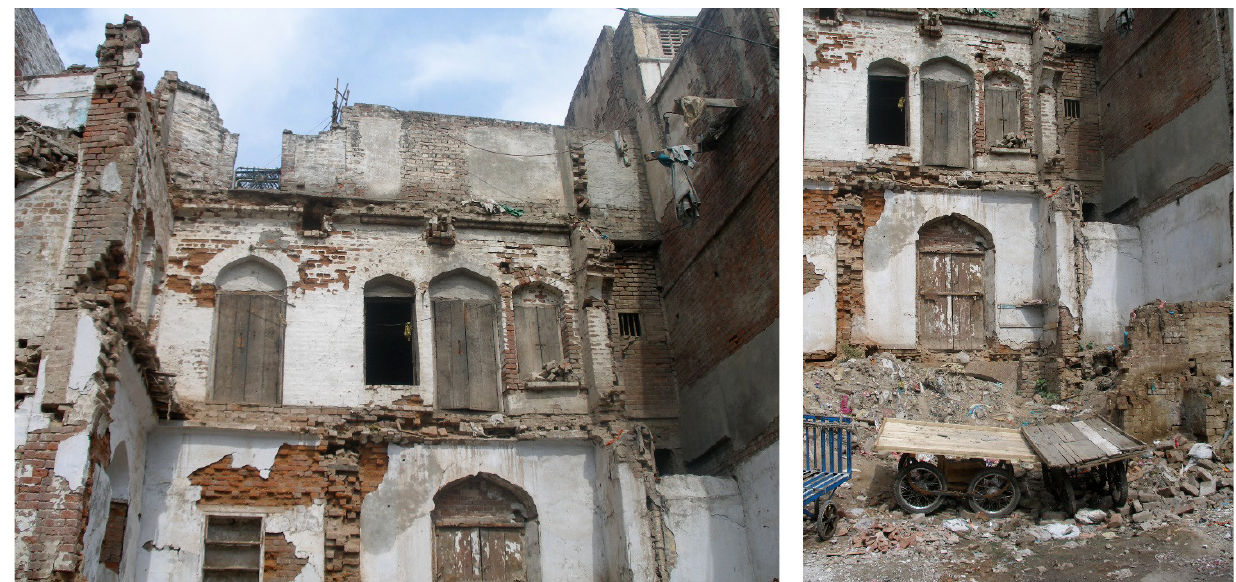
Figure 2. Dilapidated house in the Walled City. Photos by Helena Cermeño